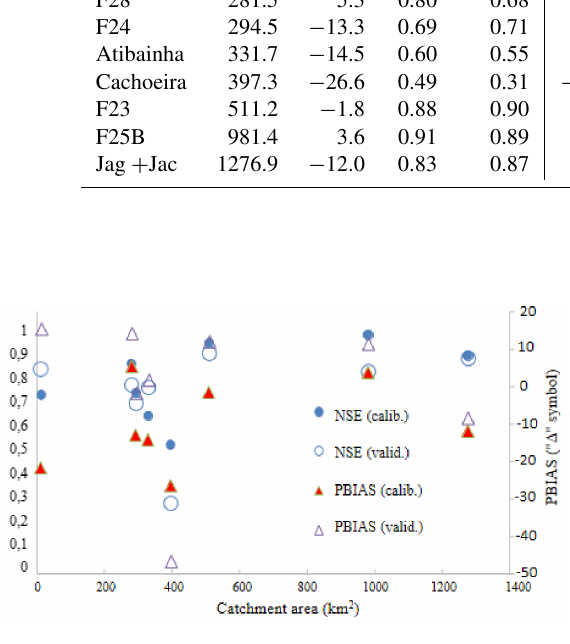
Figure 4. Model calibration related to drainage areas of catchments in the Cantareira